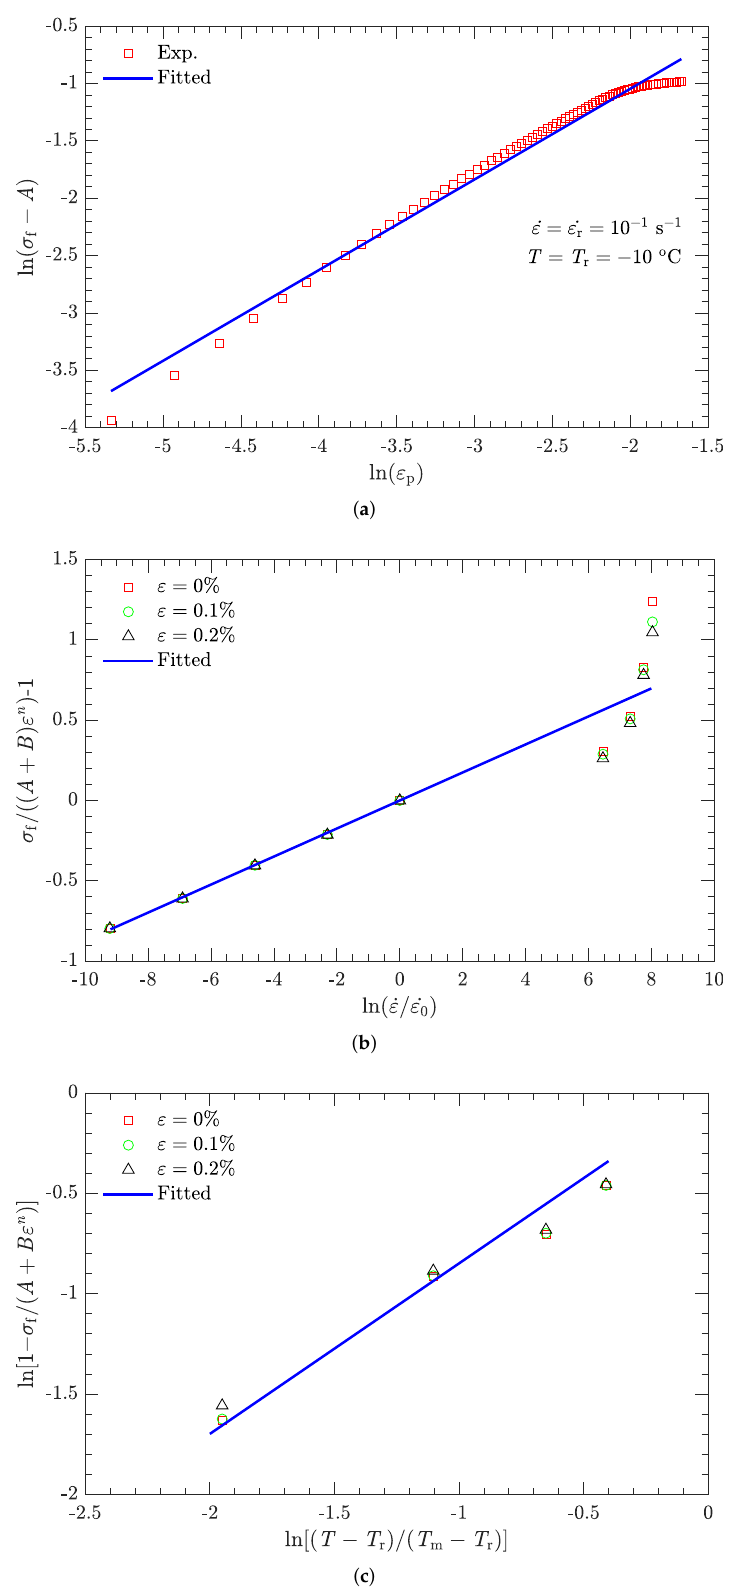
Figure 9. Linear regression for parameters A , B , n , C , and m . ( a ) Parameters A , B , and n ; ( b ) parameter C ; and ( c ) parameter m